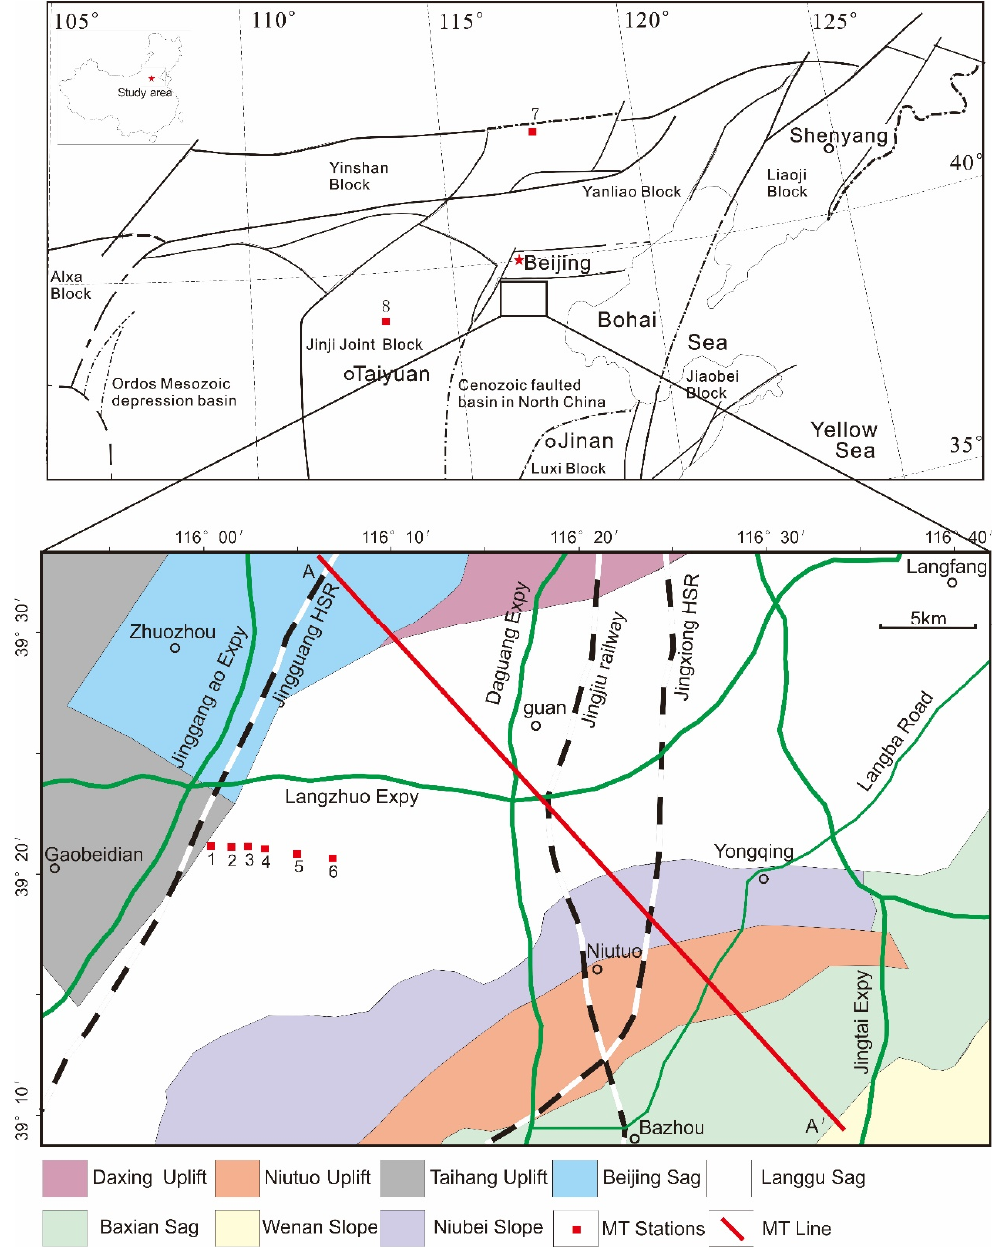
Figure 1. Simplified geological map of the Jizhong depression and the location of the MT stations.